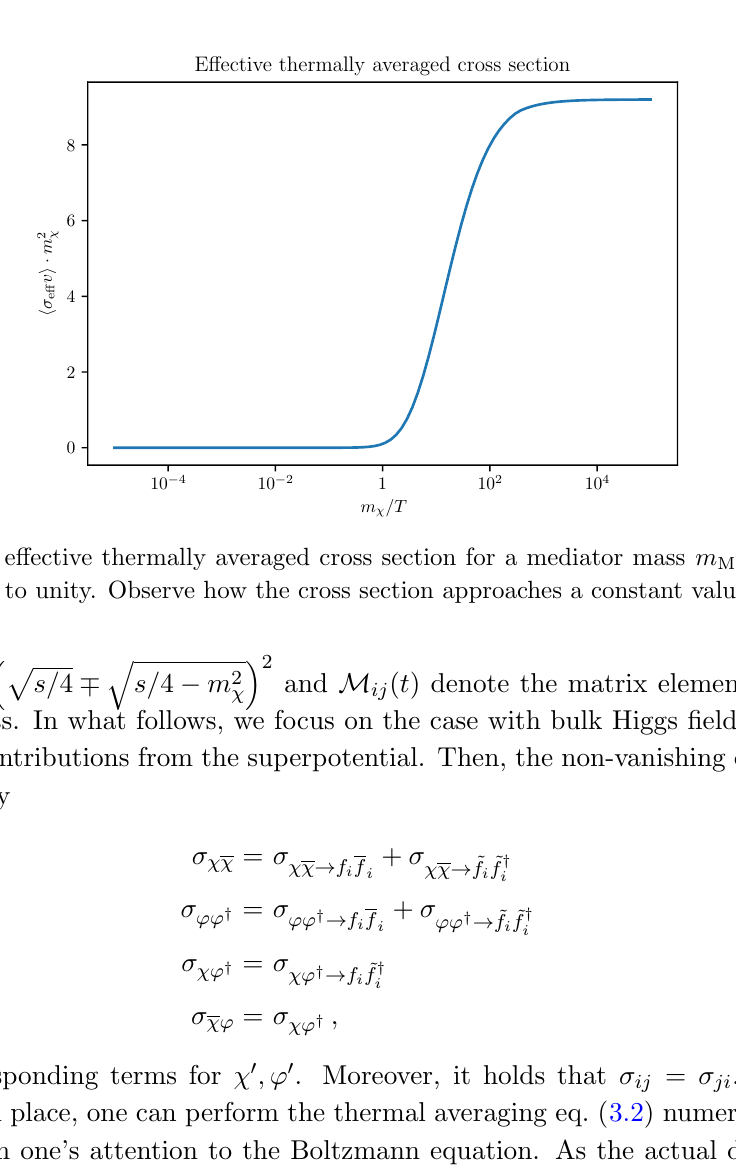
M = 1 : 8 m (cid:31) and m (cid:31) (cid:28)